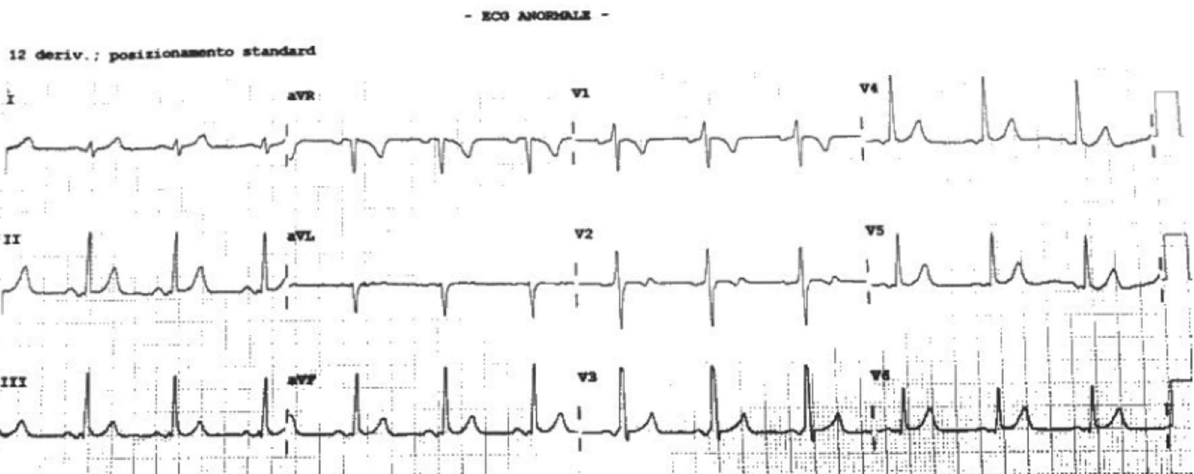
Figure 3. Resting ECG performed during non-competitive-sports screening. A short PQ-interval and a mild delta wave can be observed.